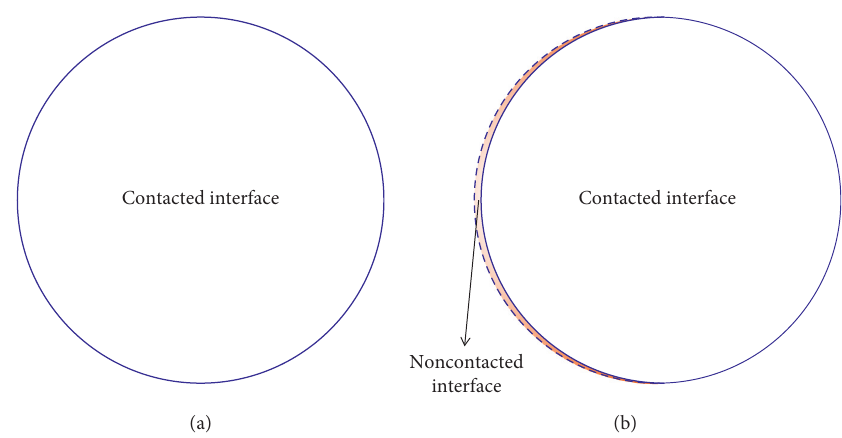
Figure 9: State of the interface in the direct shear test: (a) before the direct shear test; (b) after the direct shear